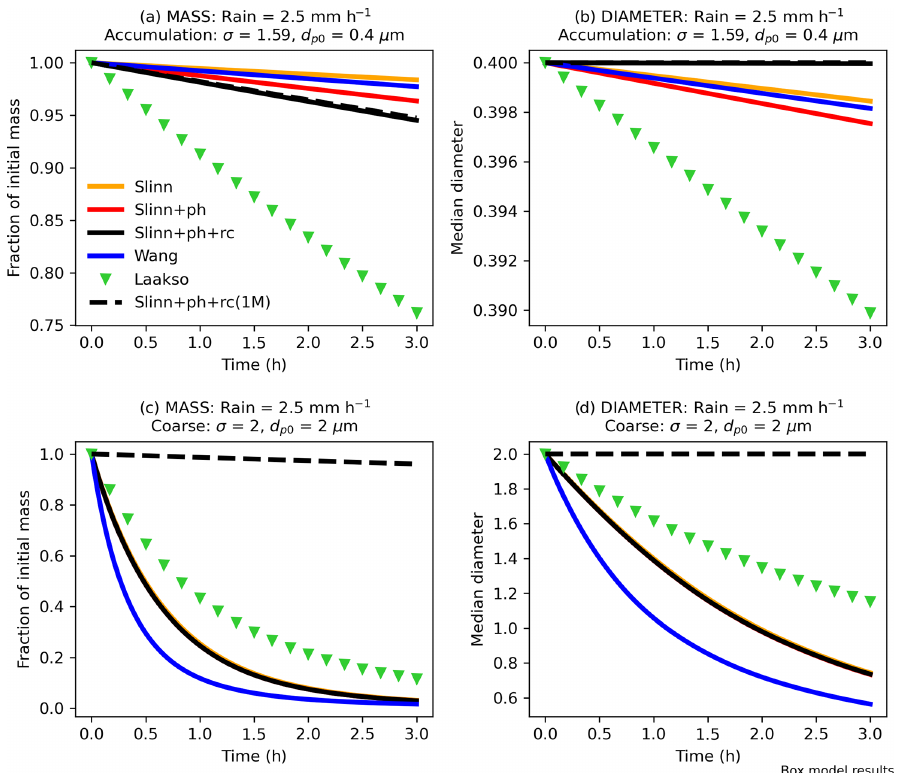
Figure 5. Time evolution of the (a, c) mass concentration and (b, d) median diameter of (a–b) an accumulation-like mode and (c–d) a coarse-like mode with a constant rain rate of 2.5mmh − 1 for six BCS schemes (see Table 1 for definitions). Results from offline box model